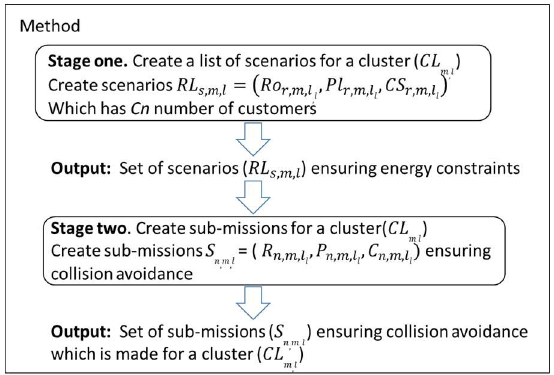
Figure 5. Illustration of the method to create sub-missions for each m th cluster in each l th flying-time window (FTW).